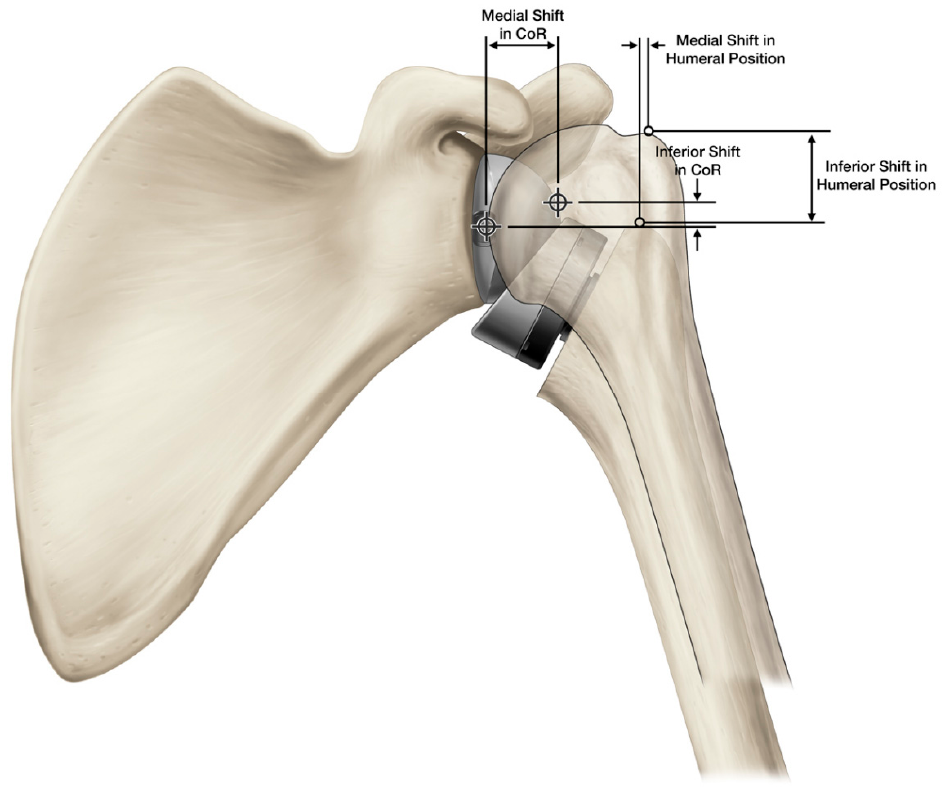
Figure 1. Inferior and medial translation of the CoR and humeral position with rTSA, relative to the native shoulder.